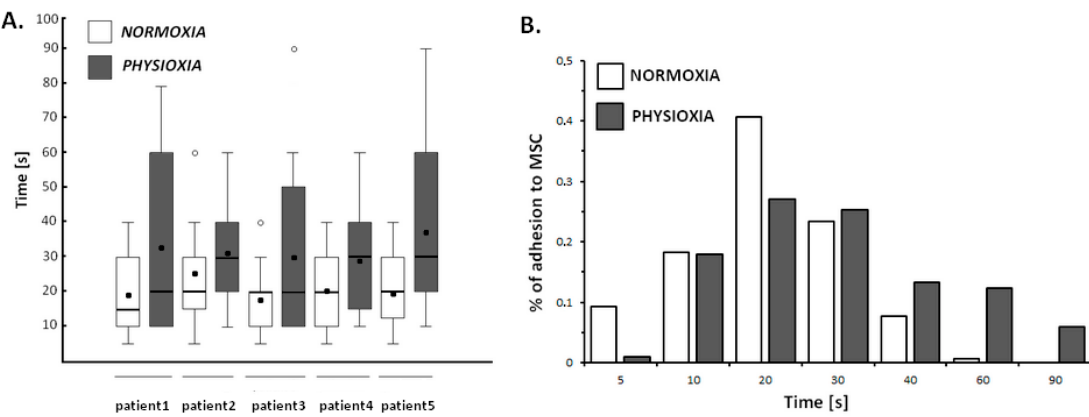
Figure 5. Box and whiskers plot of time-dependent adhesion of primary B-cells isolated from lymph node to marrow stromal cells in normoxia and physioxia. A significant difference between primary B-cells adhesion in normoxia and physioxia while considering a p -value < 0.01 was observed for all cases. The symbol ( ◦ ) indicates outliers; Student’s t -test. N = 60 for each patient in normoxia and physioxia ( A ). The distribution of time-dependent adhesion to MSC in normoxia and physioxia ( B ).